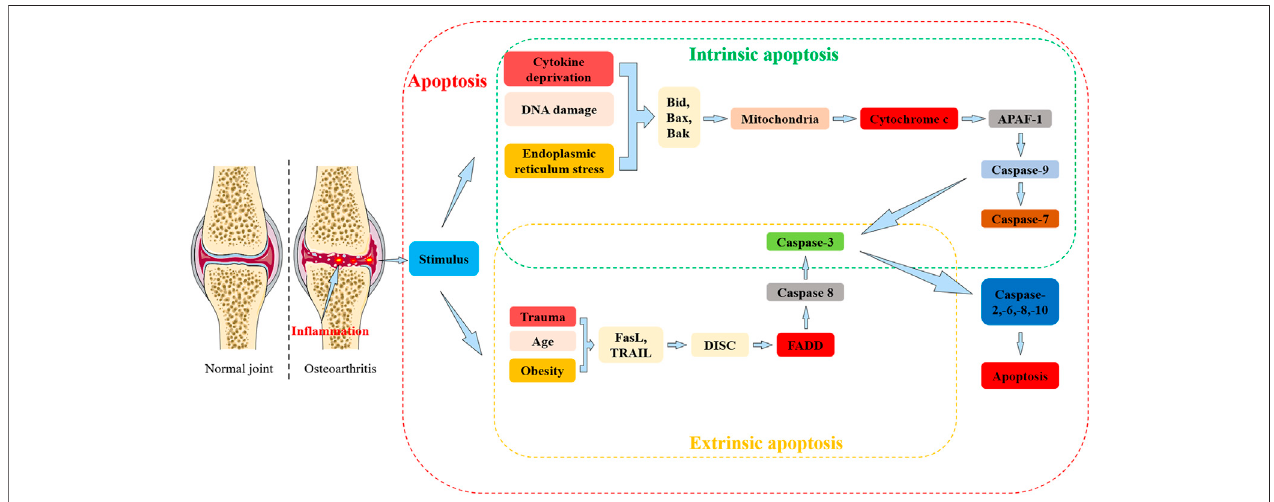
FIGURE3| Therelationshipbetweenapoptosisandosteoarthritis(OA).Apoptosis:Apoptosisiscanbedividedintoextrinsicandintrinsicpathways.Intheextrinsic pathway, death receptors (including Fas, TRAIL) are activated and bind to corresponding ligands (including FasL) in response to stimulation by risk factors for OA (including trauma, age, obesity, etc.) to form a multi-protein complex, also known as the DISC. Activation of Caspase-8 is mediated by FADD, and Caspase-8 further activates Caspase-3 to propagate apoptotic signals. In the intrinsic pathway, intracellular damage, DNA damage and endoplasmic reticulum stress lead to activation mainly in the mitochondria and endoplasmic reticulum BCL2 protein family members (including Bid, Bax, and Bak). Bcl2 protein family members can activate cytochromecwhichcanfurtheractivateapoptosisproteaseactivatingfactor-1(APAF-1)andcaspase-9.Activatedcaspase-9furtheractivatescaspases-3and-7which in turn activate caspases-2,-6,-8,-10 to create a positive feedback loop that ampli fi es the apoptotic signal and induces